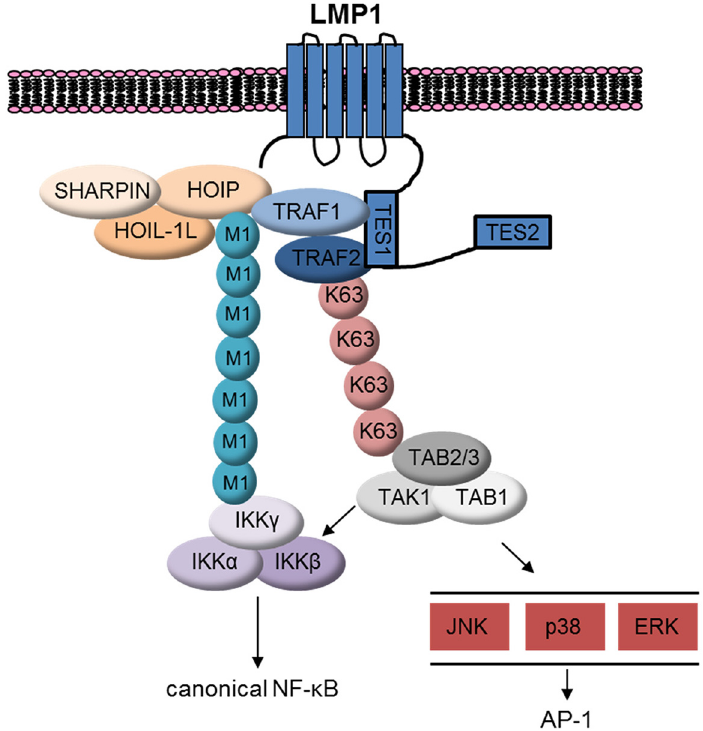
Fig 11. Schematic model. LMP1 recruits TRAF1:TRAF2, which in turn associates with LUBAC. LUBAC attaches M1-pUb chains to LMP1/TRAF1 complexes, which recruits the IKK complex. LMP1 also induces attachment of K63-pUb to TRAF2, which in turn recruits and activates the TAB/TAK1 complex. TAK1 activates downstream MAP kinase and canonical NF-kB